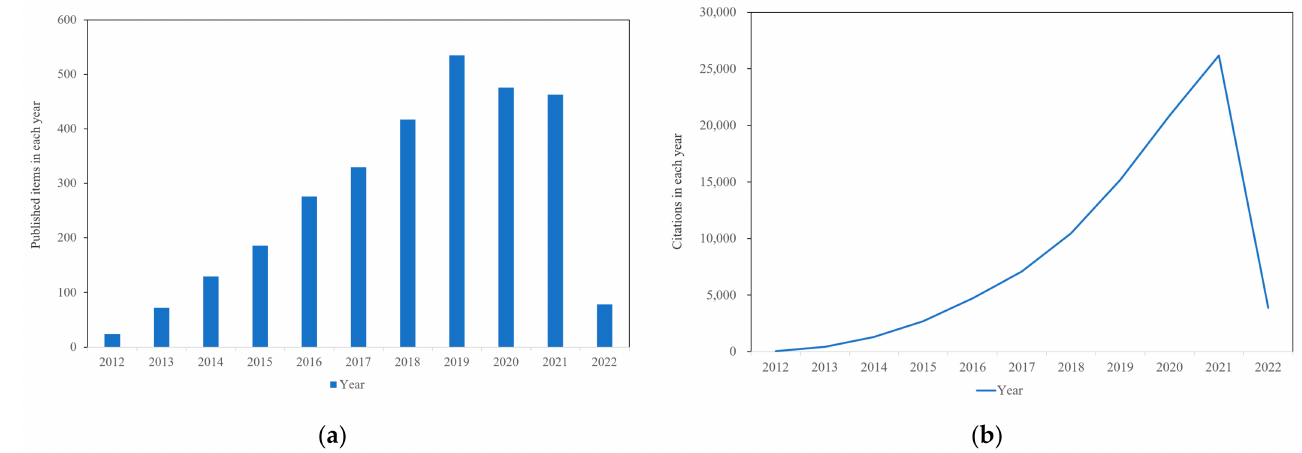
Figure 3. Trends in ( a ) publications and ( b ) citation frequency in graphene-based tissue engineering (data from Web of Science; Search strings: “graphene” and “tissue engineering”).